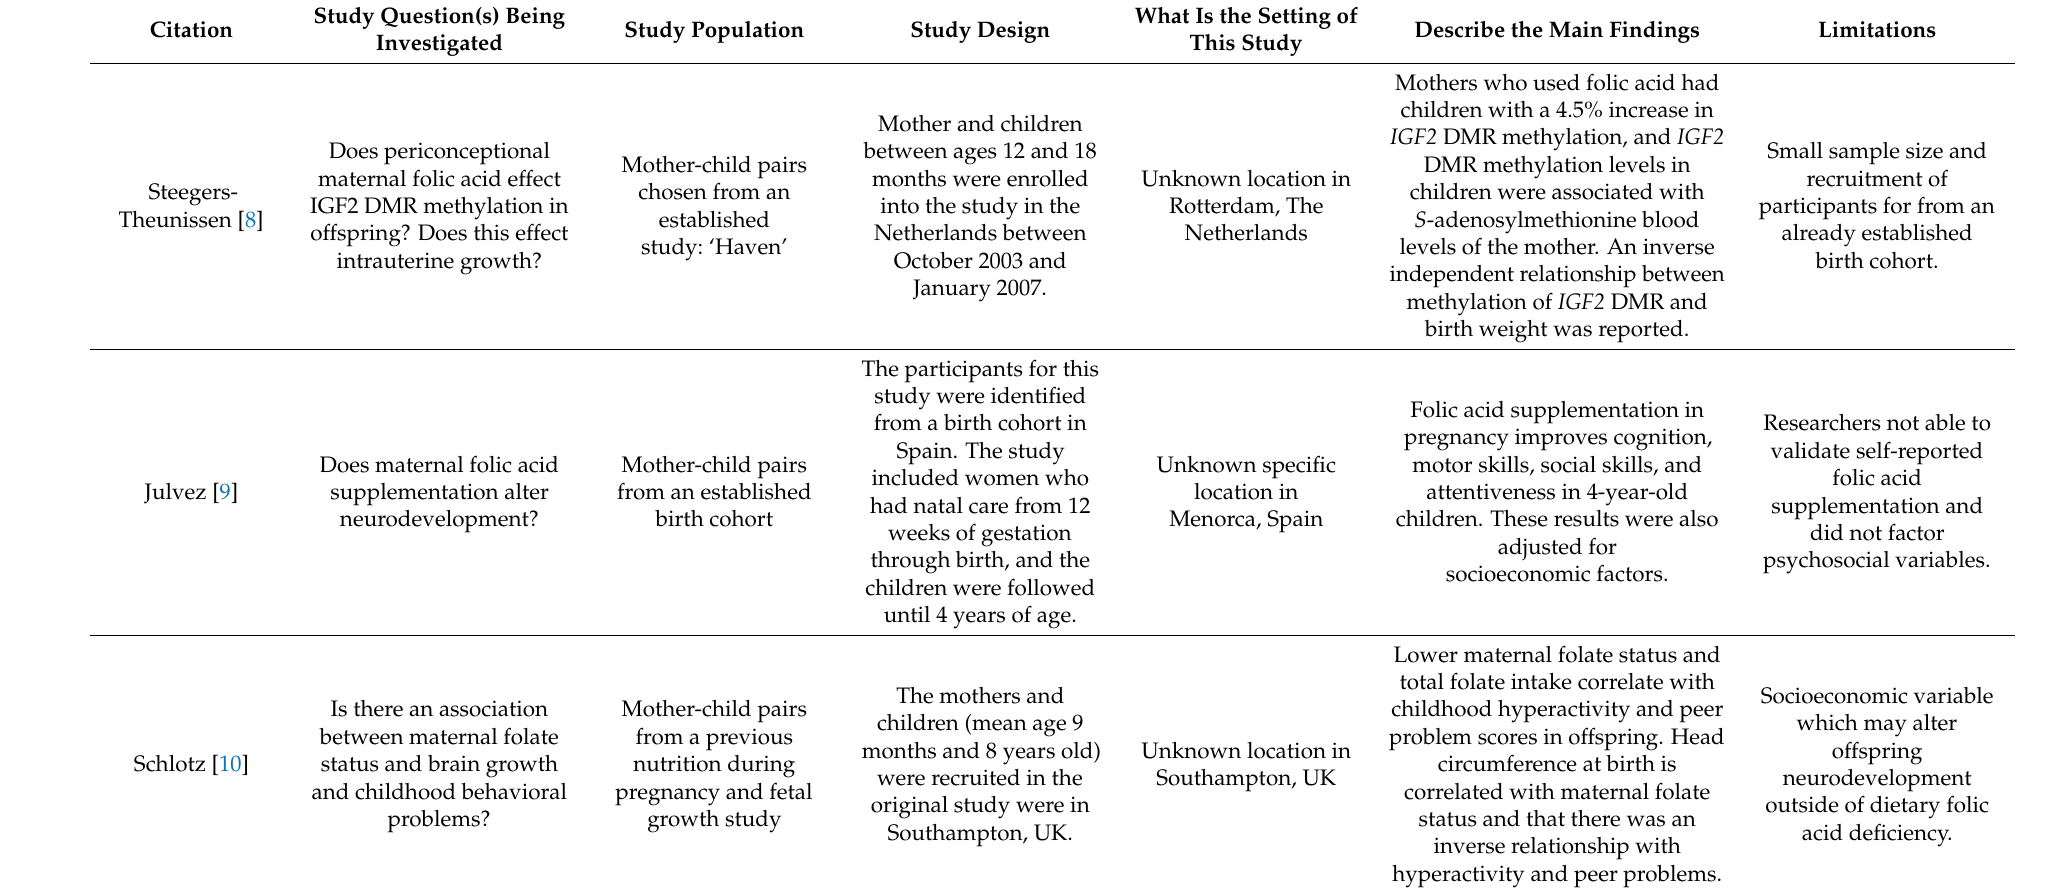
Table 1. Summary of main findings from clinical